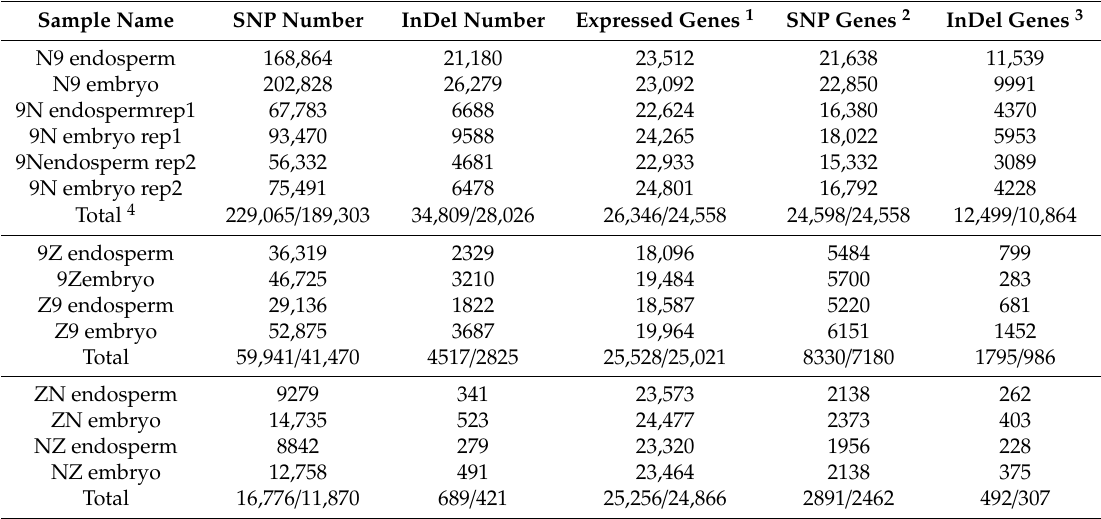
Table 1. Single Nucleotide Polymorphisms (SNPs) and Insertion and Deletion (InDels) identified in each